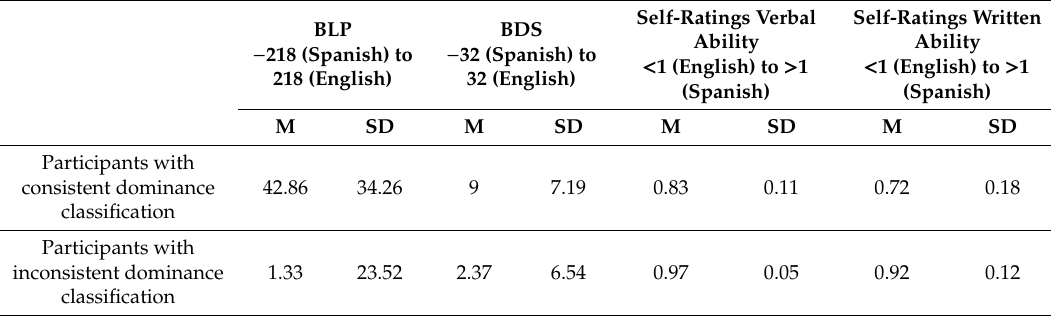
Table 5. Average dominance scores by